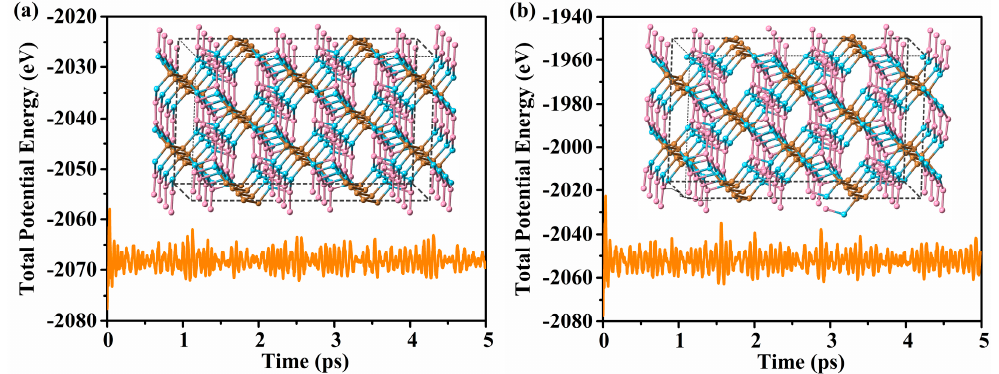
Figure 4. The total energy fluctuations of Penta-C 20 as a function of the AIMD simulation at 300 K ( a ) and 800 K ( b ). The insets are the atomic configurations of 2 × 2 × 3 supercell of Penta-C 20 at the end of the 5 ps AIMD simulation.